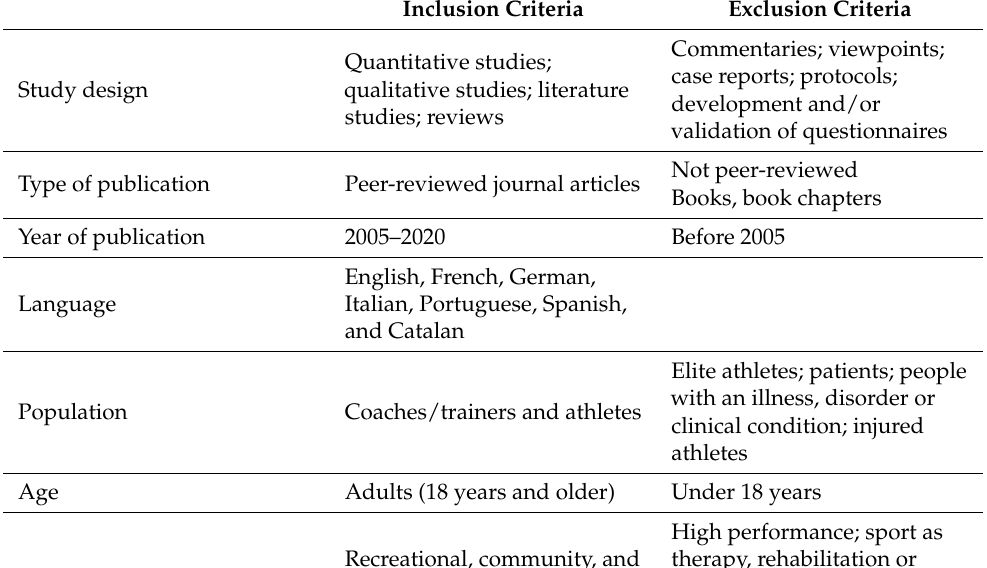
Table 1. Inclusion and exclusion